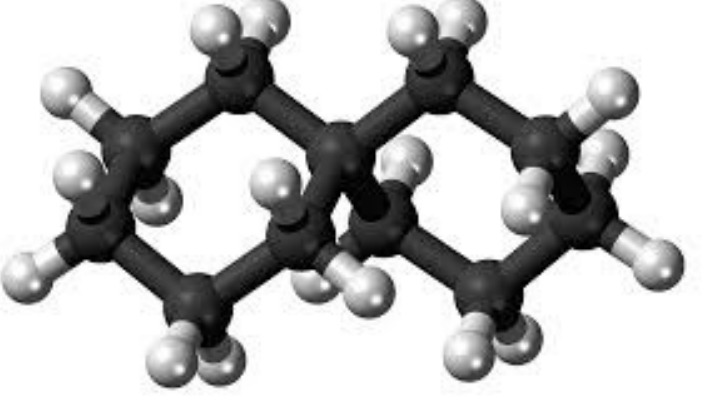
Figure 7. Molecular graph of polycyclic